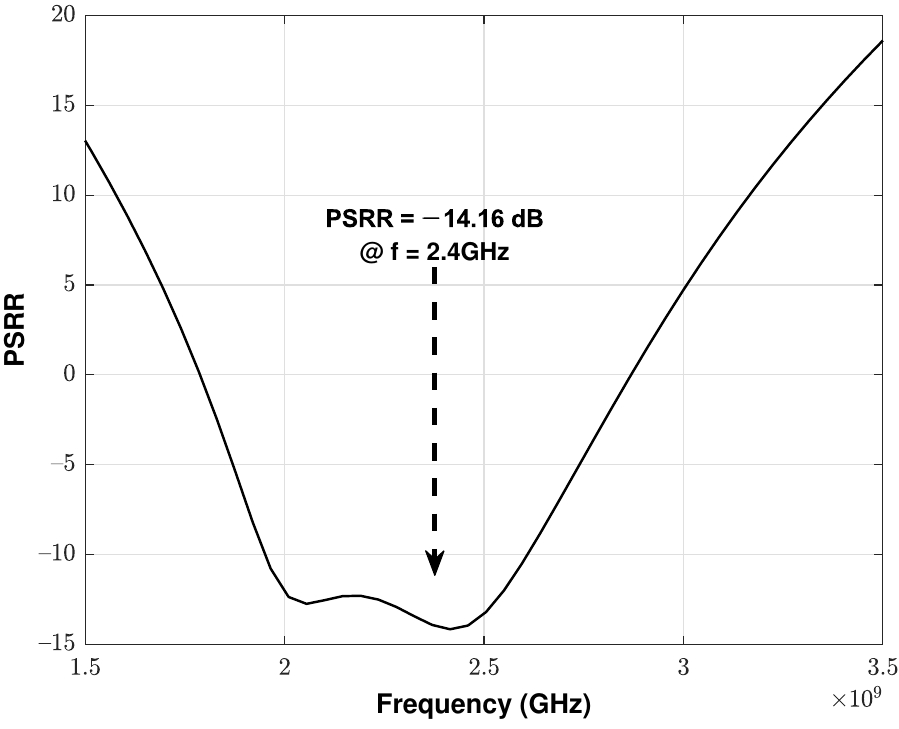
Figure 9. PSRR vs.